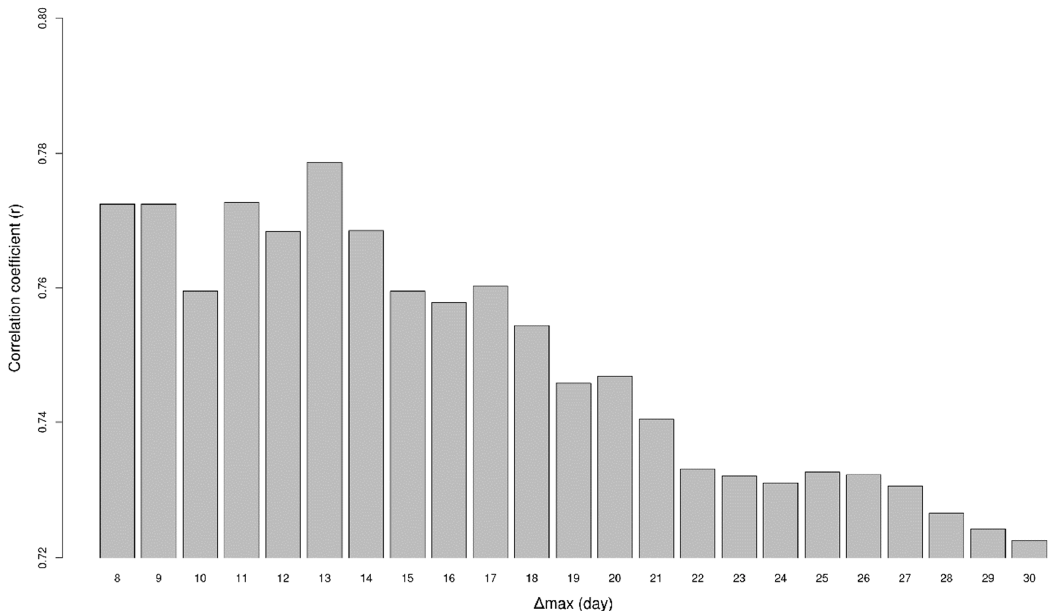
Figure 4. Correlation coefficient (r) between the standard deviation of the reported DOYs for the flowering onset of lesser celandine and the average GDD for ∆ Max values varying from one week to 30 days.